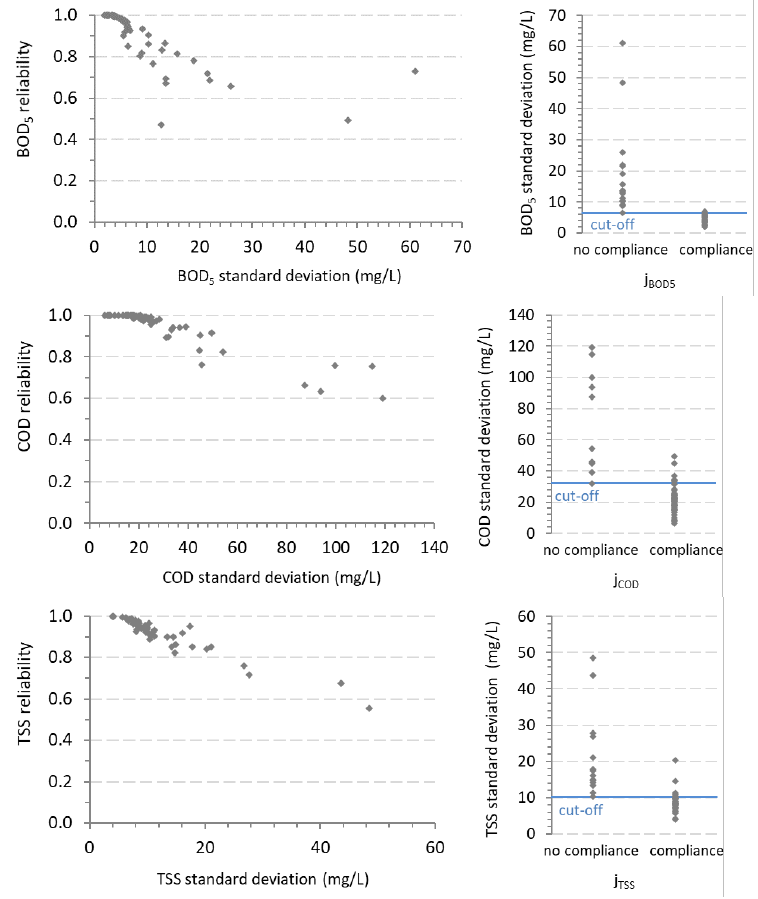
Figure 3. Plant reliability vs. standard deviation and standard deviation vs. compliance with EU discharge requirements for urban WWTPs towards BOD 5 , COD, and TSS (5-year data, 16 activated sludge WWTPs).